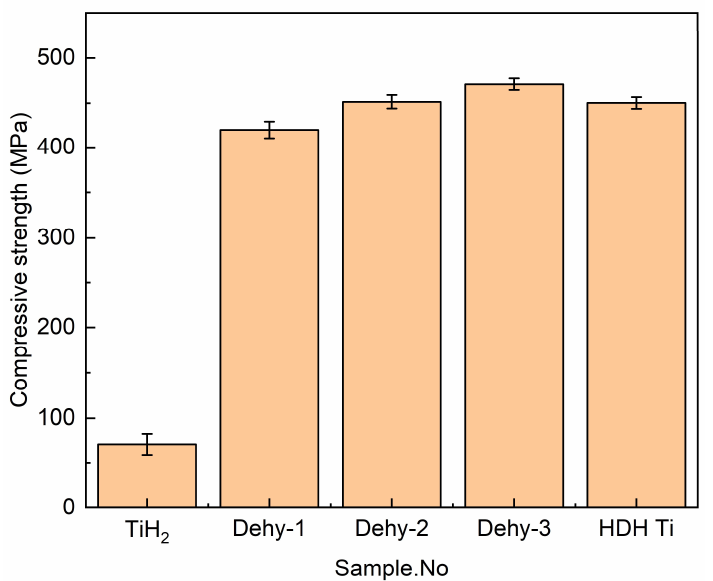
Figure 6. The Compressive strength of TiH 2 , Dehy-1, Dehy-2, Dehy-3, and HDH Ti compacts.